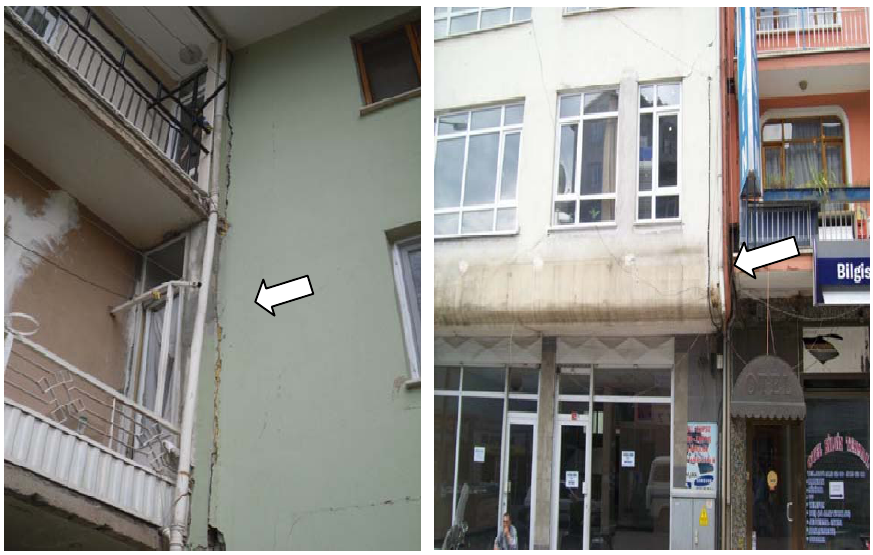
Figure 15. Pounding between closely spaced